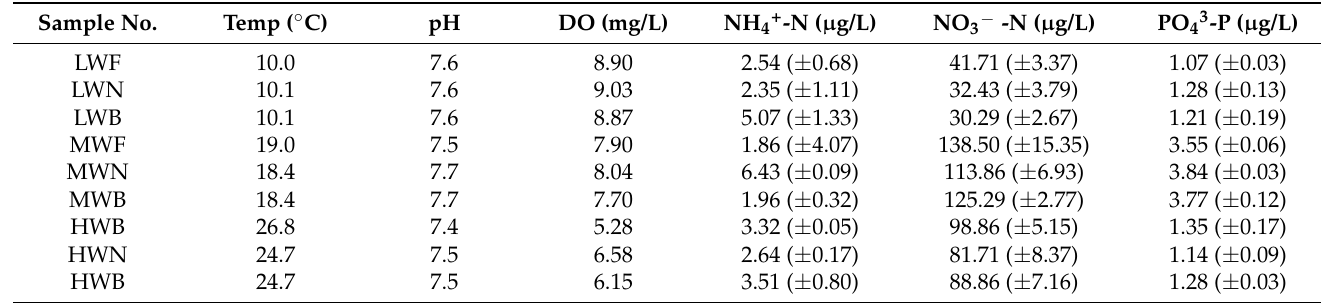
Table 2. General information on the three filtration systems in the present study. Values are shown by average ± standard deviation (n = 3).